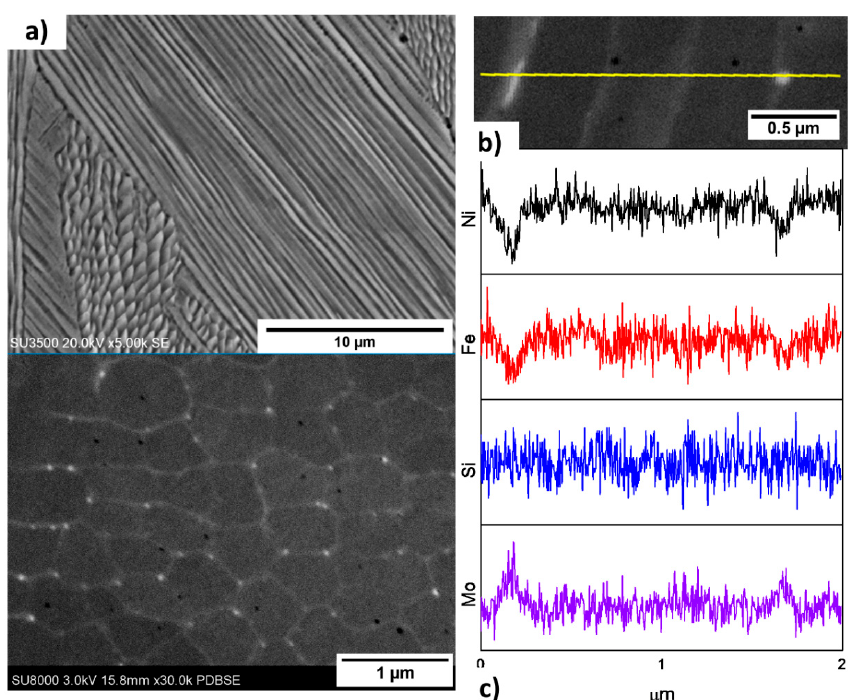
Figure 3. ( a ) SEM micrograph showing the typical columnar microstructure obtained from